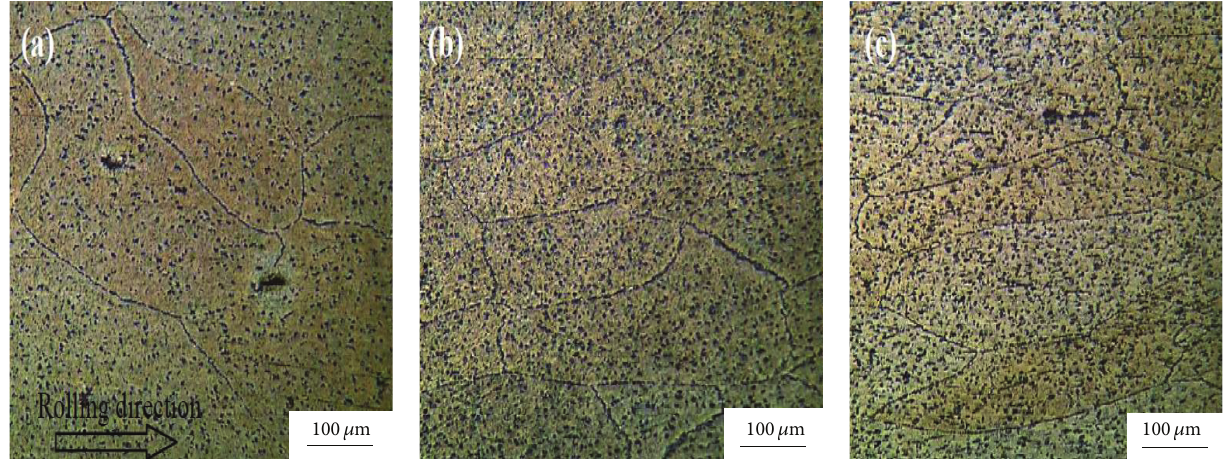
Figure 9: Micrograph of LAZ1151: (a) 30% cold rolling, average grain size ∼ 227 𝜇 m, (b) 60% cold rolling, average grain size ∼ 171 𝜇 m, and (c) 90% cold rolling, average grain size ∼ 147 𝜇 m [11].